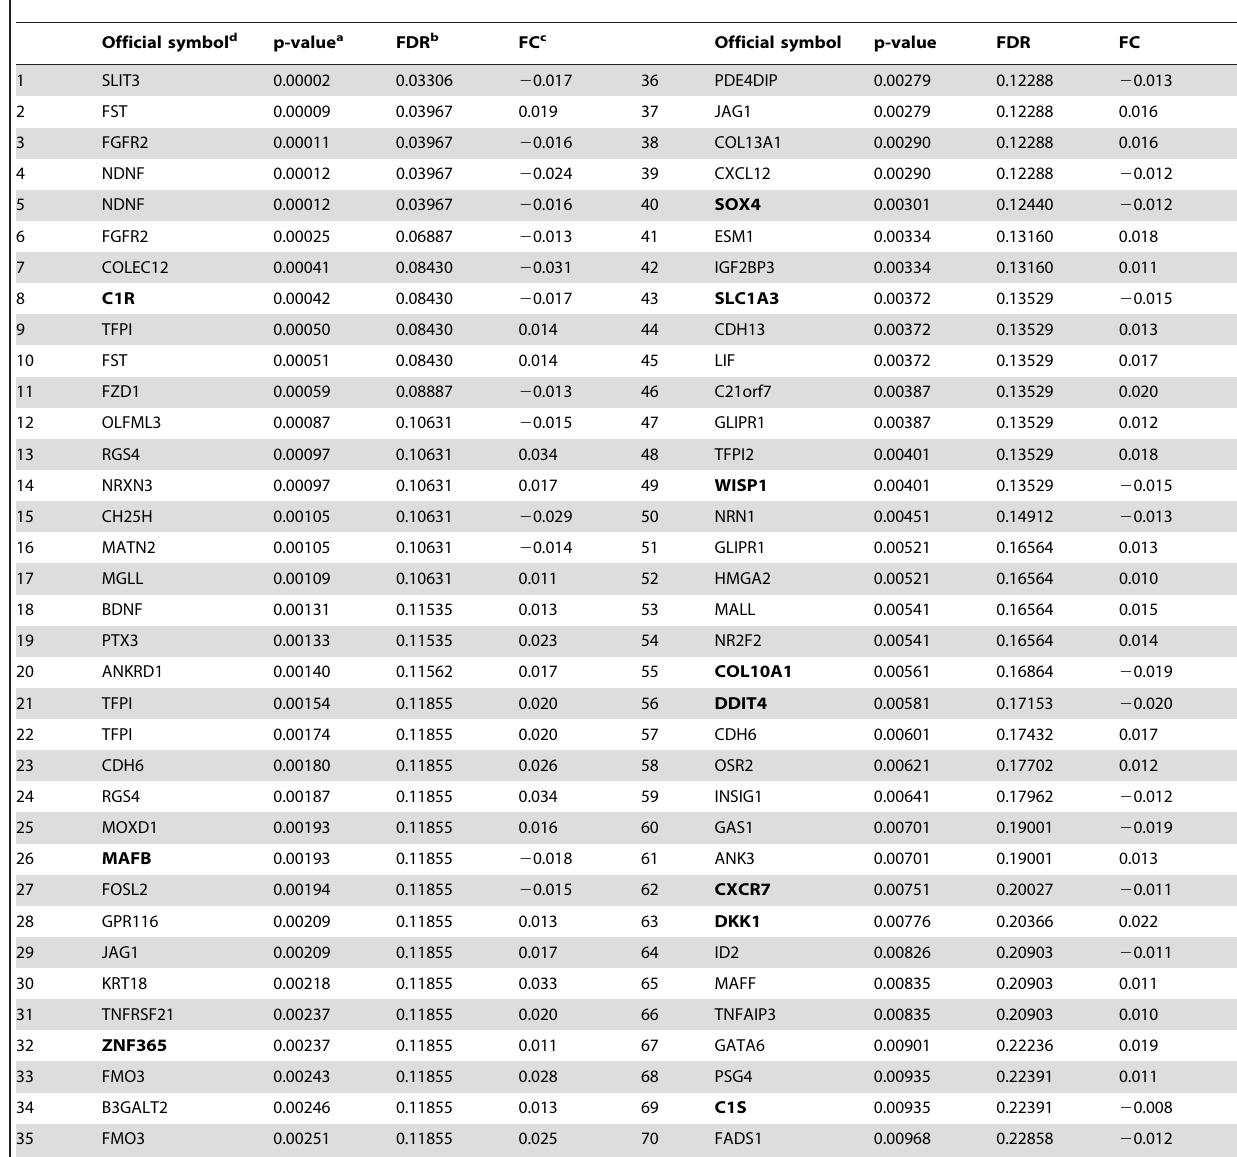
Table 2. List of genes correlating in hMSCs with donor age (p , 0.01) based on